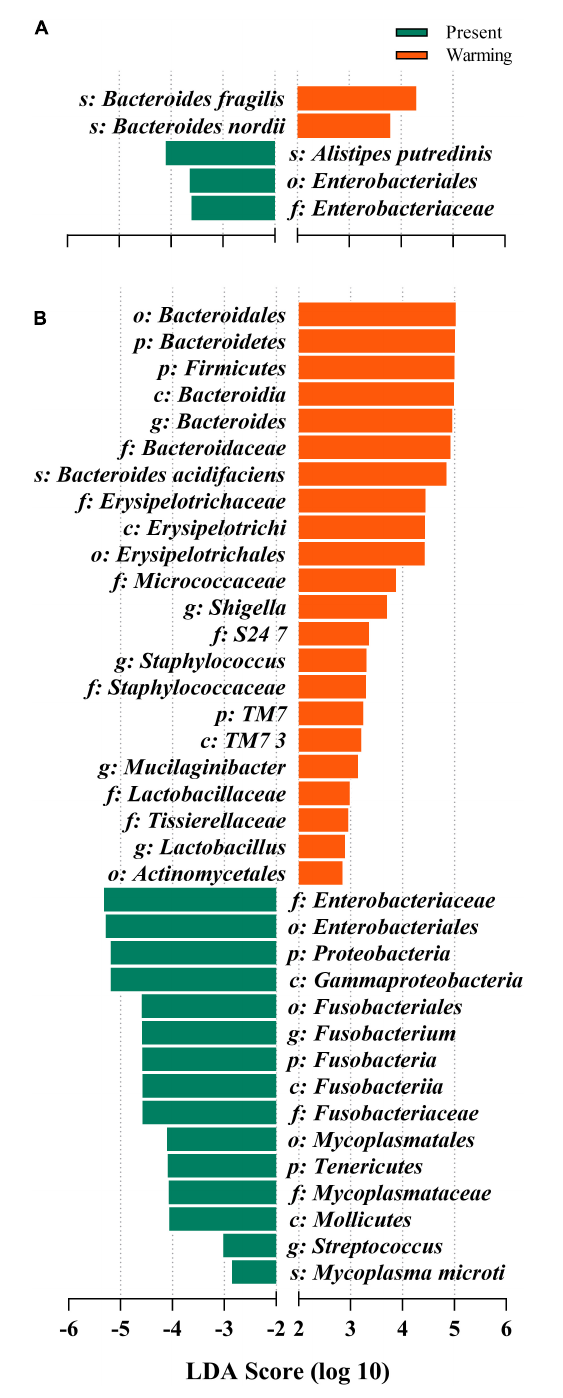
FIGURE5 Differences in bacterial taxa determined by linear discriminative analysis of effect size (LEfSe) of (A) Eremias argus and (B) Takydromus amurensis . The highlighted taxa were significantly enriched in the group that corresponds to each color ( P < 0.05). Linear discriminatory analysis ( LDA ) scores can be interpreted as the degree of difference in relative abundance. Green- and orange-colored bars indicate the present and warming